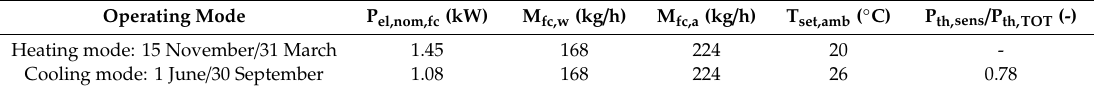
Table 3. Fan coils data